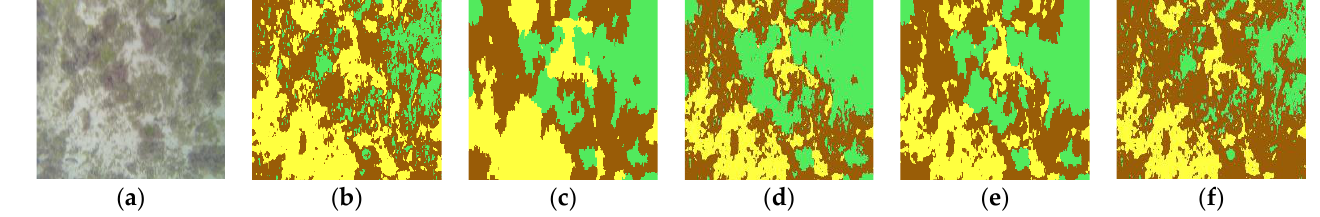
Figure 11. Validation tests of the proposed segmentation algorithms using highly illuminated and low contrast brown algae image (1) from Figure 9 as example of two categories: ( a ) original image; ( b ) ground truth image; ( c ) FF result; ( d ) FR result; ( e ) OS result; ( f ) KM result. Brown: brown algae and yellow: sediments.